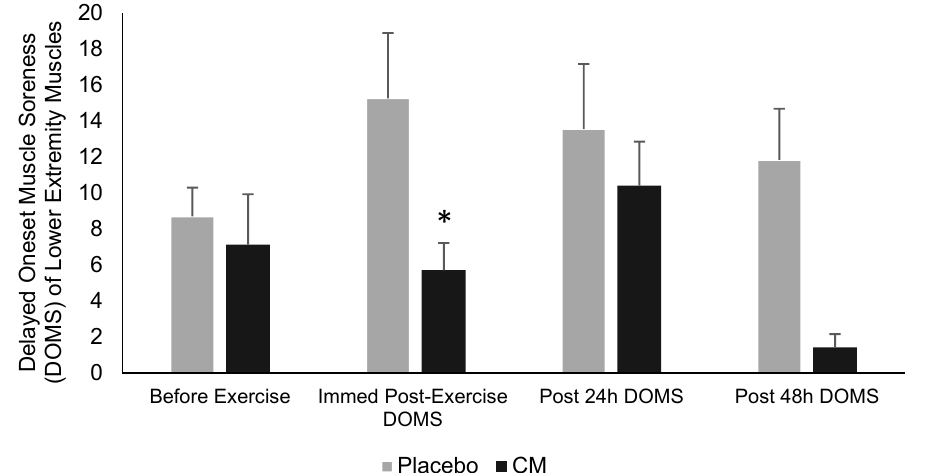
Figure 3. Subjective measurements of delayed onset soreness of lower extremity muscles before exercise, immediately post-exercise, 24 h post-exercise, and 48 h post-exercise for each training session of week placebo and week chocolate milk. Values are mean ± SD ( p < 0.05) (* = Significantly different ( p < 0.05) from week placebo). Table 4. Subjective measurements of RPE and delayed onset soreness of upper body and lower body in the placebo and chocolate milk interventions. Values are mean ± SD ( p < 0.05) (* = Significantly different ( p < 0.05) from week placebo).